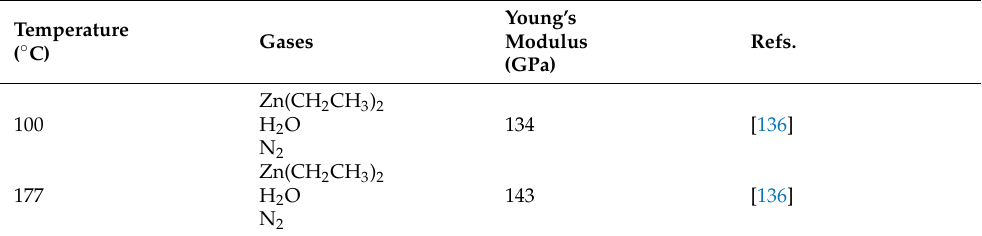
Table 18. Residual Stresses of ZnO Deposited using ALD methods.